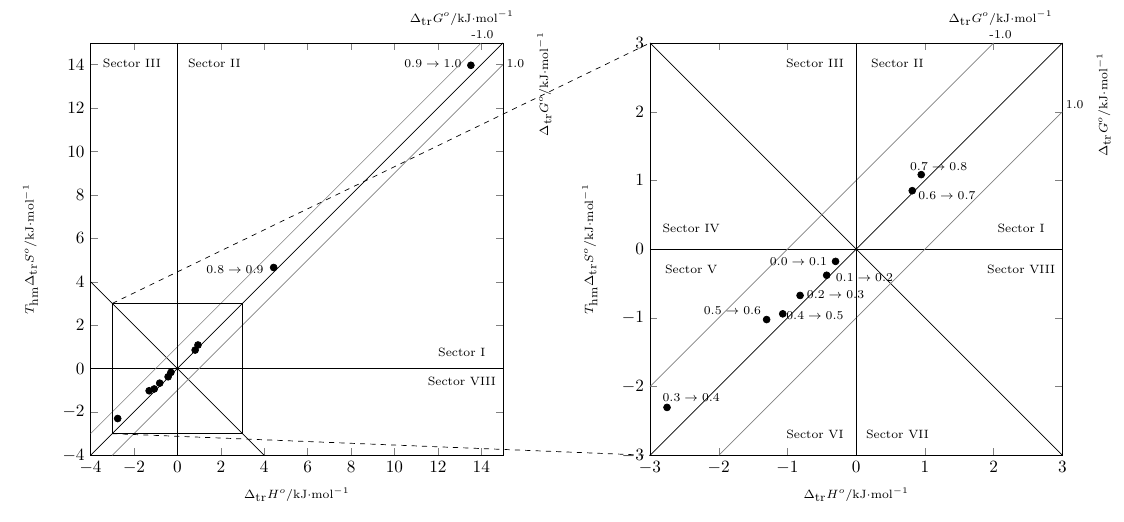
Figure 9. Relation between enthalpy ( ∆ tr H o ) and entropy ( T hm ∆ tr S o ) of the process transfer of isoniazid (3) in (PEG 200 (1) + water (2)) cosolvent mixtures at 297.6 K. The isoenergetic curves for ∆ o are represented by dotted mix G